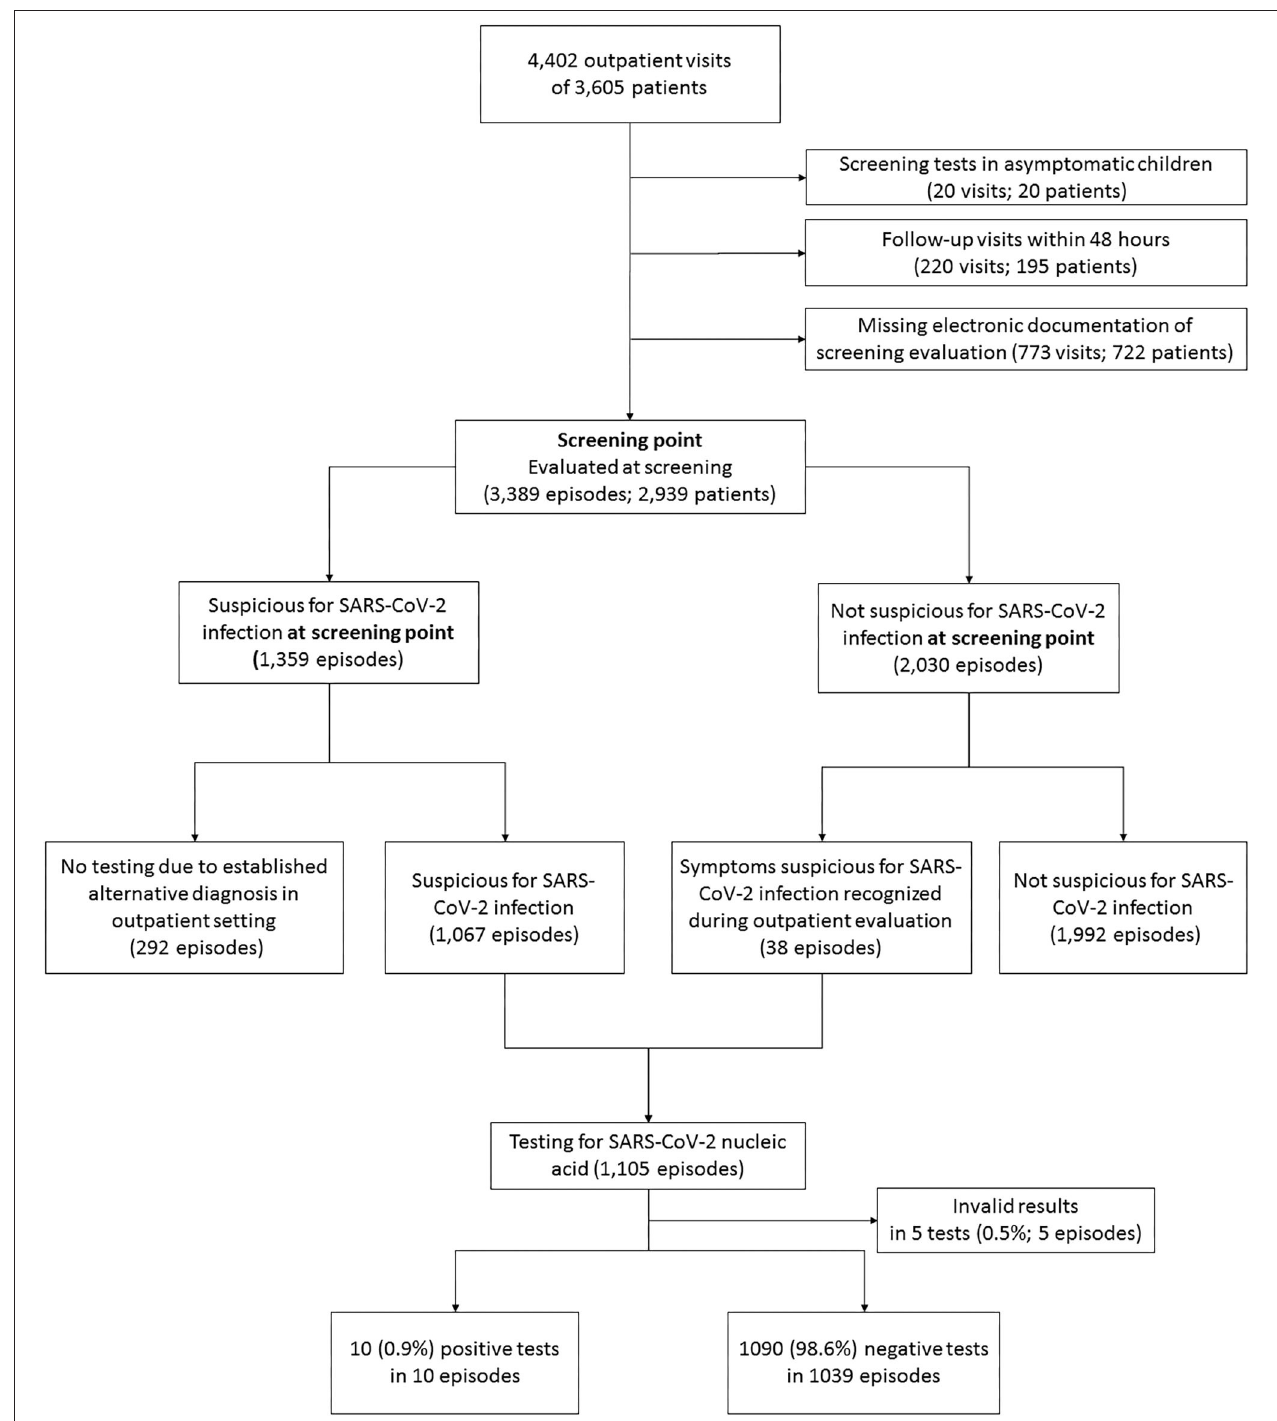
FIGURE 1 | Flow chart of excluded and analyzed patients. A total of 595 of 3,605 patients (16.5%) had more than one visit. The range of visits per patient was 1 to 10.